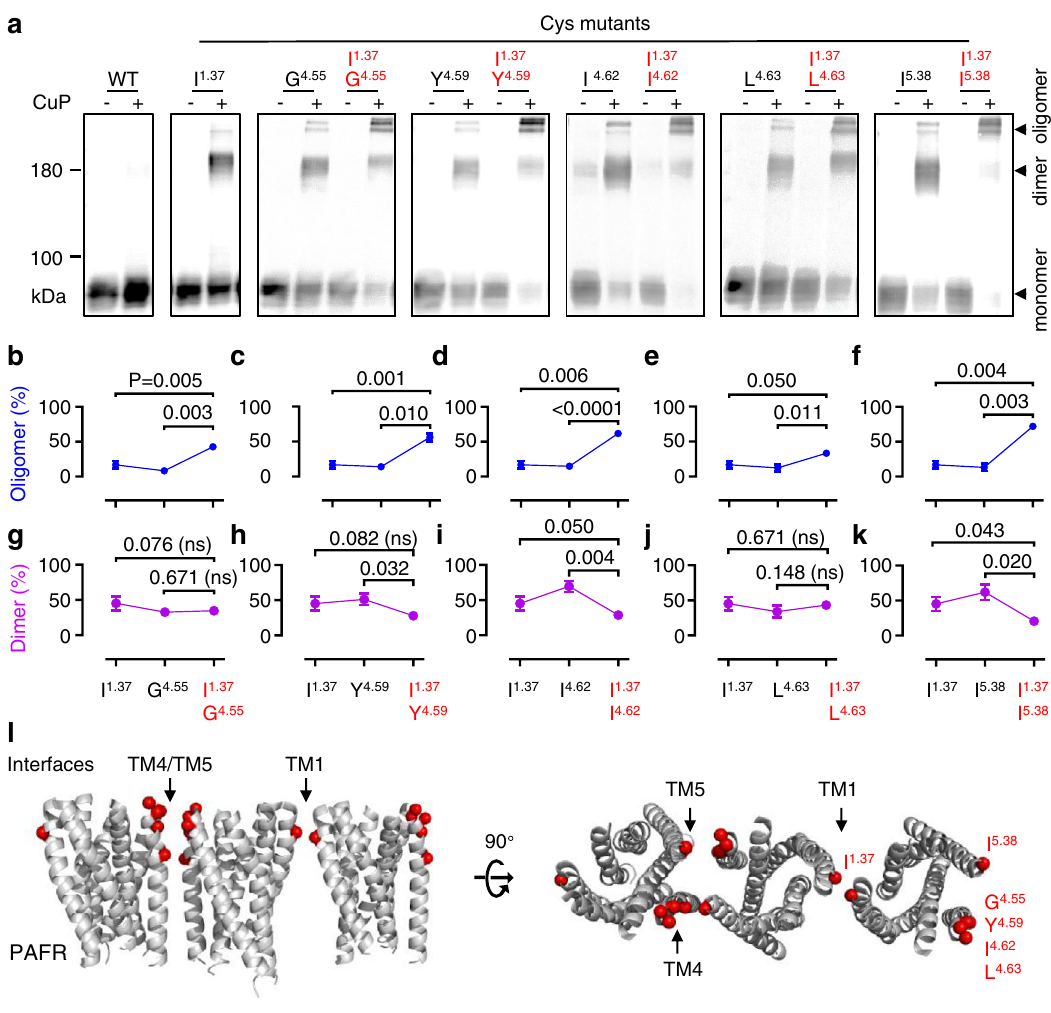
Fig. 3 | Double cross-linking at TM1 – TM4 or TM1 – TM5 contributes to higher- order PAFR oligomers. a Cross-linking of the indicated subunits containing Cys substitutions in TM1, TM4, and TM5 after treatment (+) or without treatment ( − ) with CuP. Data are representative of a typical experiment from n =3 biologically independent experiments. b – k Dimer/oligomer ratio of the indicated mutants